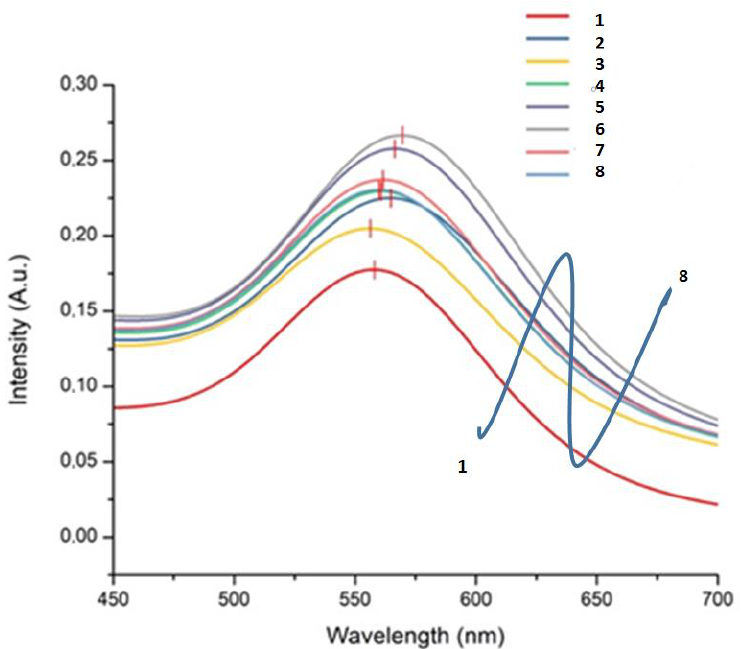
Figure 4. LSPR spectra in the presence of five gliadin concentrations and anti-IgG antibody in ethanol solvent for biofunctionalization of metallic nanostructures: (1) annealed 4 nm AuNPs; (2) MUA/AuNPs; (3) anti-gliadin/MUA/AuNPs; (4) 0.1 ppm gliadin; (5) 1 ppm gliadin; (6) 10 ppm gliadin; (7) 100 ppm gliadin; (8) 1000 ppm gliadin. (A.u.—absorbance units).